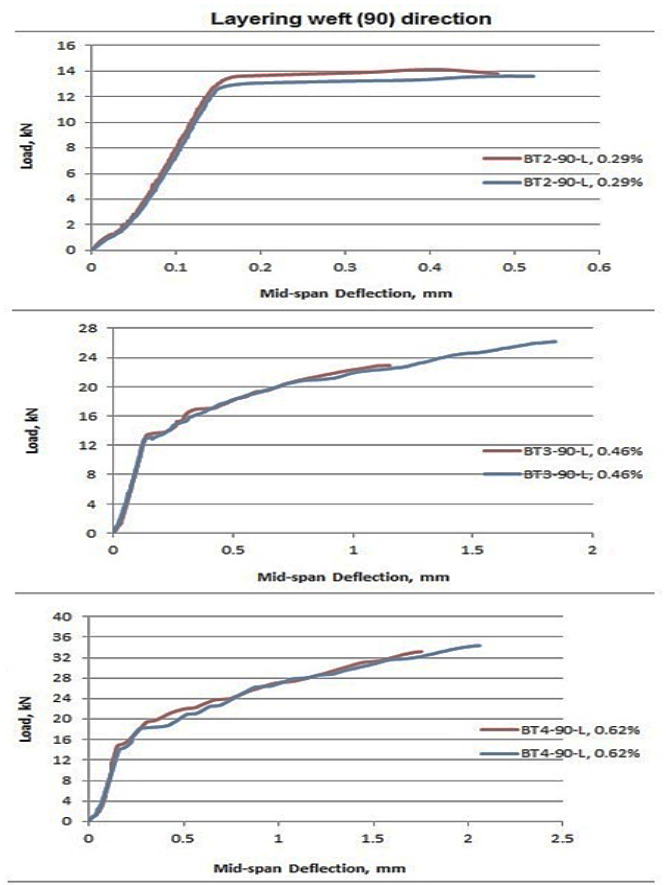
Figure 8. Mid-span load-deflection of TRC beams with various layers of woven fabric (2.5 cm) at warp direction.